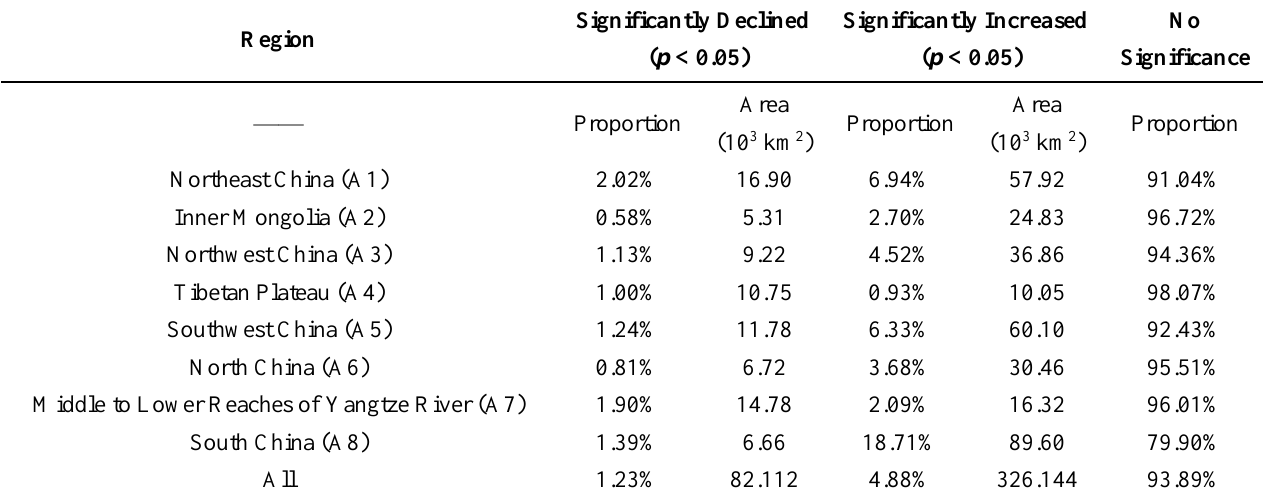
Table 4. Significance of slopes in